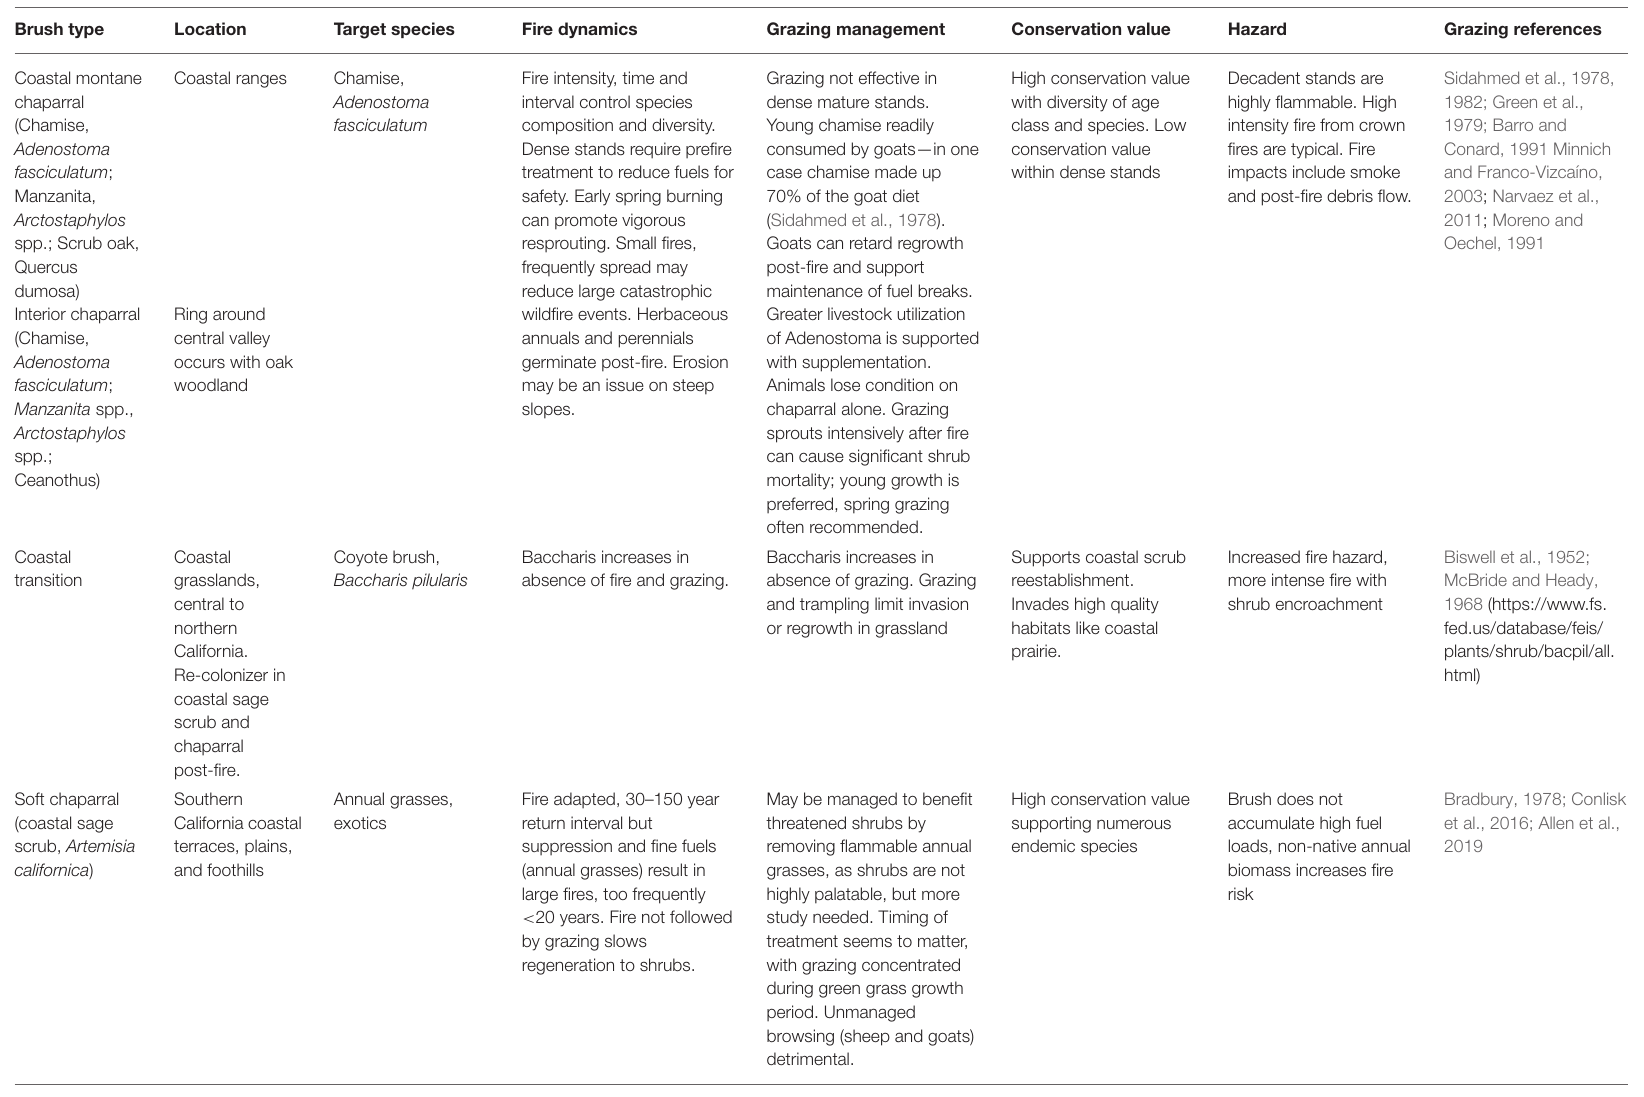
TABLE 3 | Examples of fire and grazing relationships in 4 shrub types in four regions of California [General references: Sampson and Jespersen (1963), United States Department of Agriculture (2021)]. Brush type Location Target species Fire dynamics Grazing management Conservation value Hazard Grazing